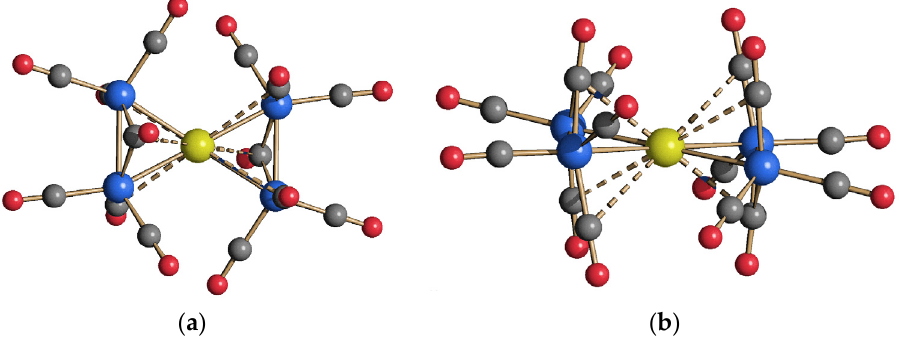
Figure 8. Two views of the molecular structure of the ( a , b ) [Au{Co 2 (CO) 7 } 2 ] − ( 6 ) anion as found in Na 2 ( 7 )( 6 )·6H 2 O. Sub Van der Waals Au ··· C(O) contacts are represented as fragmented lines (yellow, Au; blue, Co; red, O; grey, C). Selected bond distances (Å): Au-Co 2.5235(7) and 2.5579(7); Co-Co 2.4848(11).